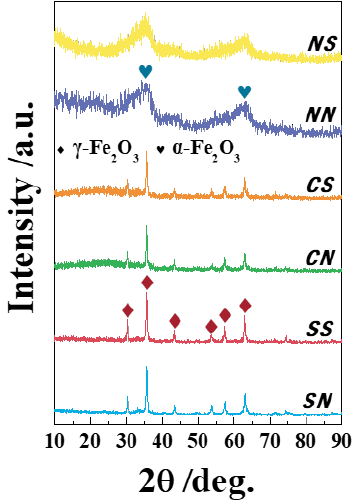
Figure 2. Powder X-ray di ff raction (XRD) patterns of titanium modified FeMgO x catalysts with di ff erent precursors.